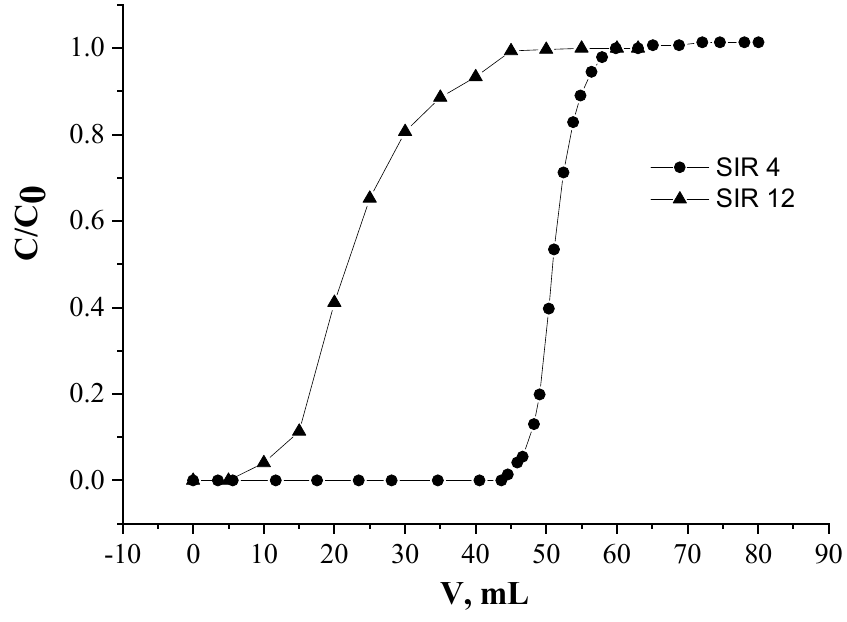
Figure 9. Frontal loading curves of Nd(III) for SIR 4 and SIR 12 in HNO 3 of 0.001 mol/L.